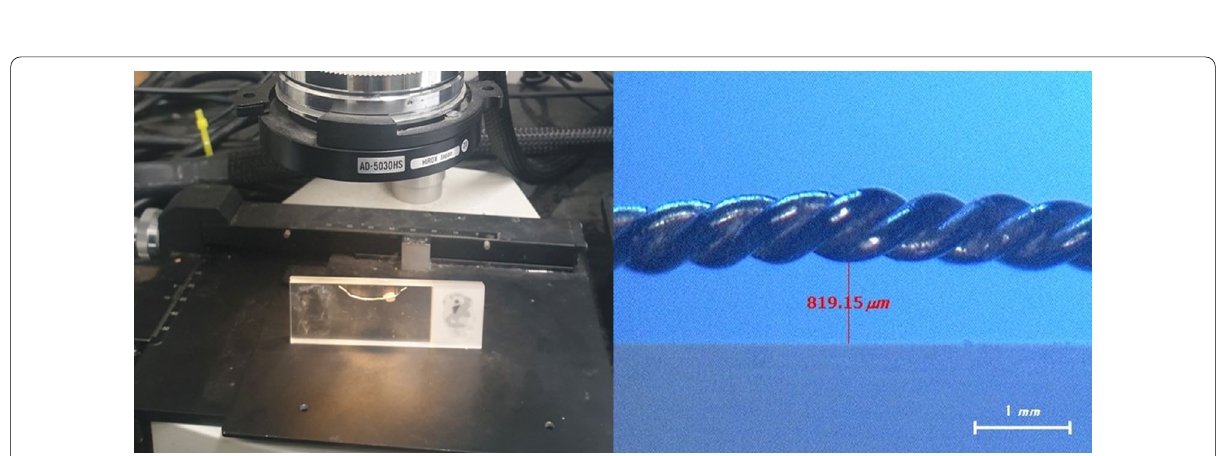
Fig. 5 Measurement of flatness deformation (70